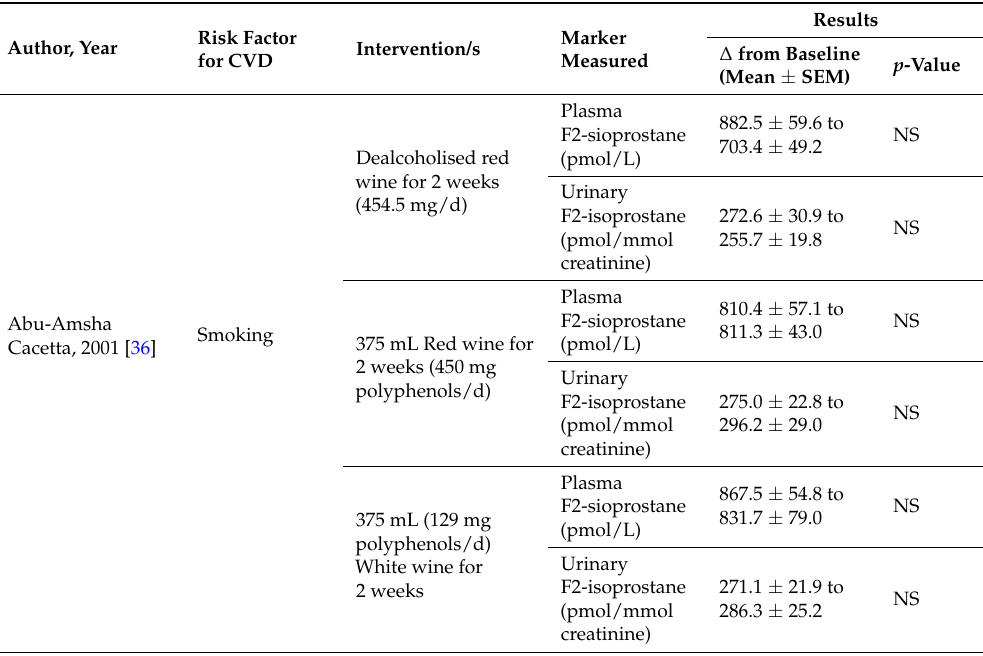
Table 12. Effect of wine on oxidative